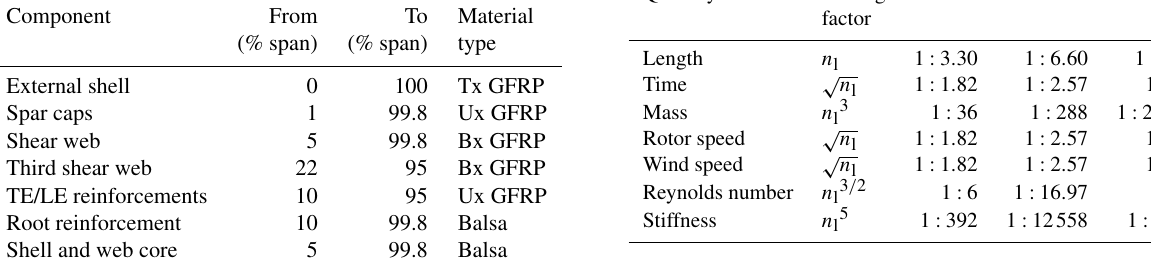
Table 6. Some key scaling factors for the W, S, and T models. Quantity